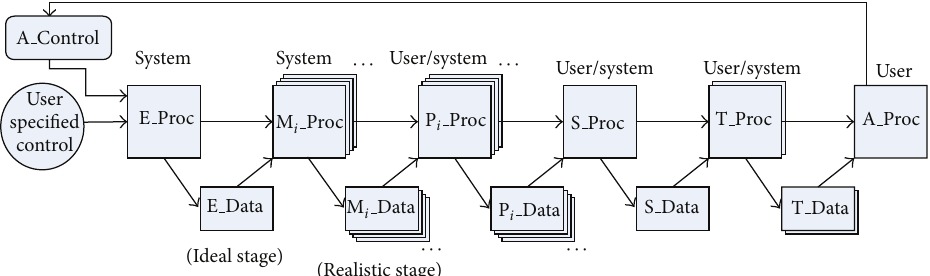
Figure 8: Illustration of the structure of the overall process and